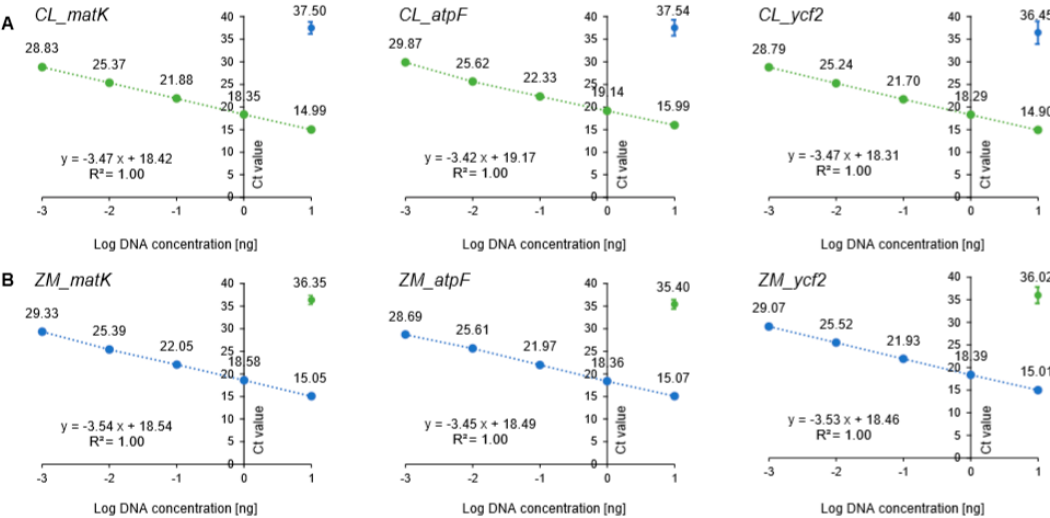
Figure 2. Standard curve of cycle threshold (Ct) values were obtained on the basis of e ffi ciency and correlation of coe ffi cient ( R 2 ) in serial dilution series genomic DNA ( C. longa and Z. mays ) using species-specific primer sets. The x -axis represents log DNA concentration (ng) and the y -axis represents means of Ct value ± SD. ( A ) C. longa targeting primer sets (CL_matK, CL_atpF, and CL_ycf2). Green dots represent serial dilution series of genomic DNA in C. longa leaves (10ng–1pg) and blue dots represent genomic DNA of Z. mays (10ng); ( B ) Z. mays targeting primer sets (ZM_matK, ZM_atpF, and ZM_ycf2). Blue dots represent serial dilution series of genomic DNA in Z. mays leaves (10ng–1pg) and green dot represents genomic DNA of C. longa (10ng). The real-time PCRs were carried out in triplicate ( n = 3).